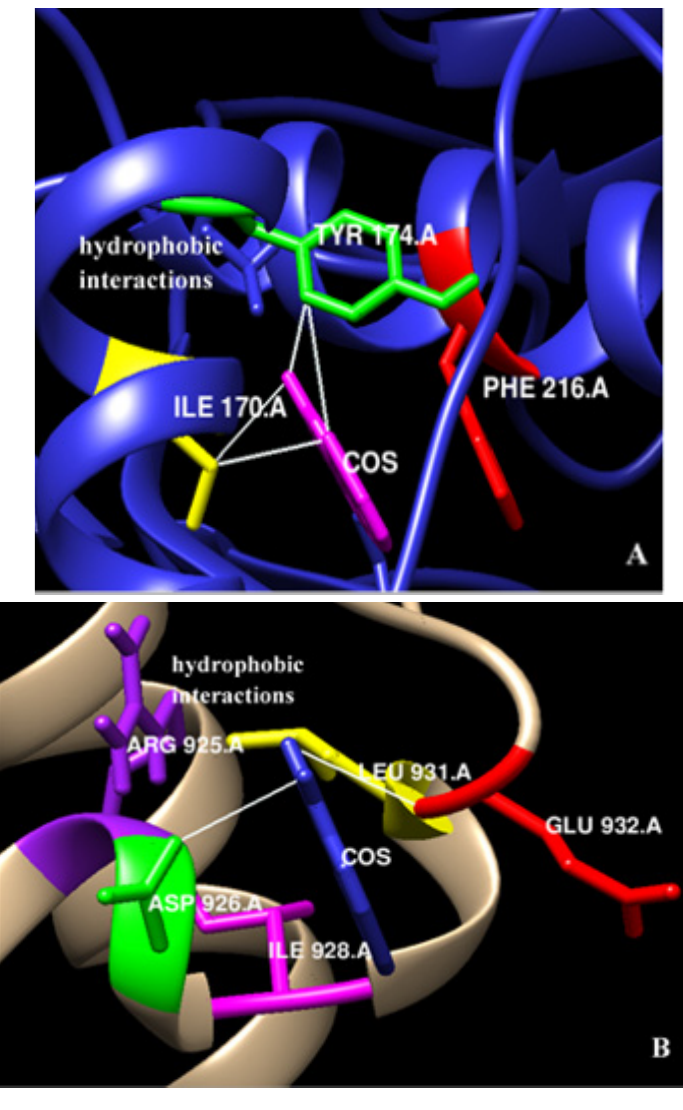
Figure 5. 3D representation of the interaction of EpCAM and Myc with costunolide. ( A ) Amino acids Ile170A (yellow), Tyr174A (green) and Phe216A (red) of EpCAM displayed hydrophobic interactions (represented by white lines—few interactions were shown) with costunolide (magenta). ( B ) Amino acids Arg925A (purple), Asp926A (green), Ile928A (magenta), Leu931A (yellow), and Glu932A (red) of Myc displayed hydrophobic interactions (represented by white lines—few were shown) with costunolide (navy blue).